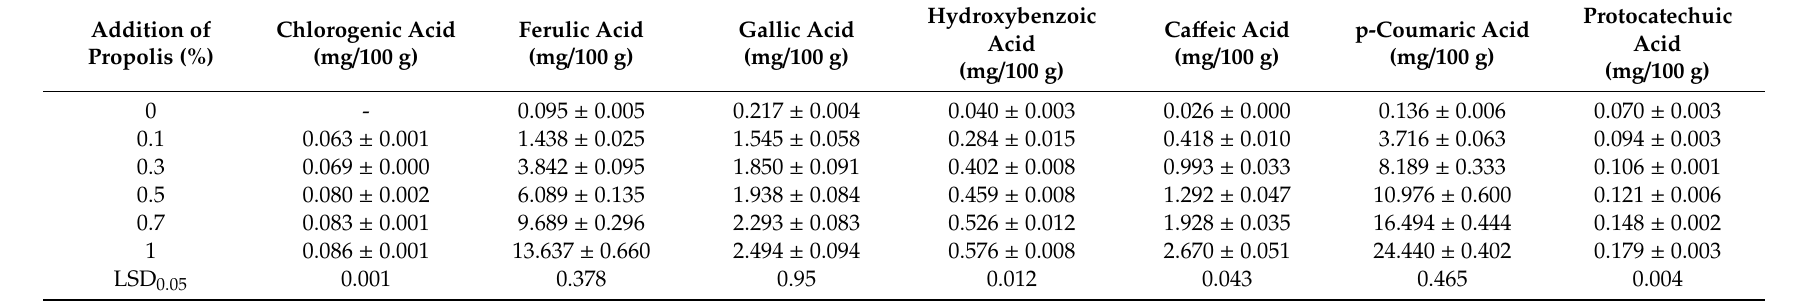
Table 3. The content of phenolic acids in multifloral honey and honey enriched with